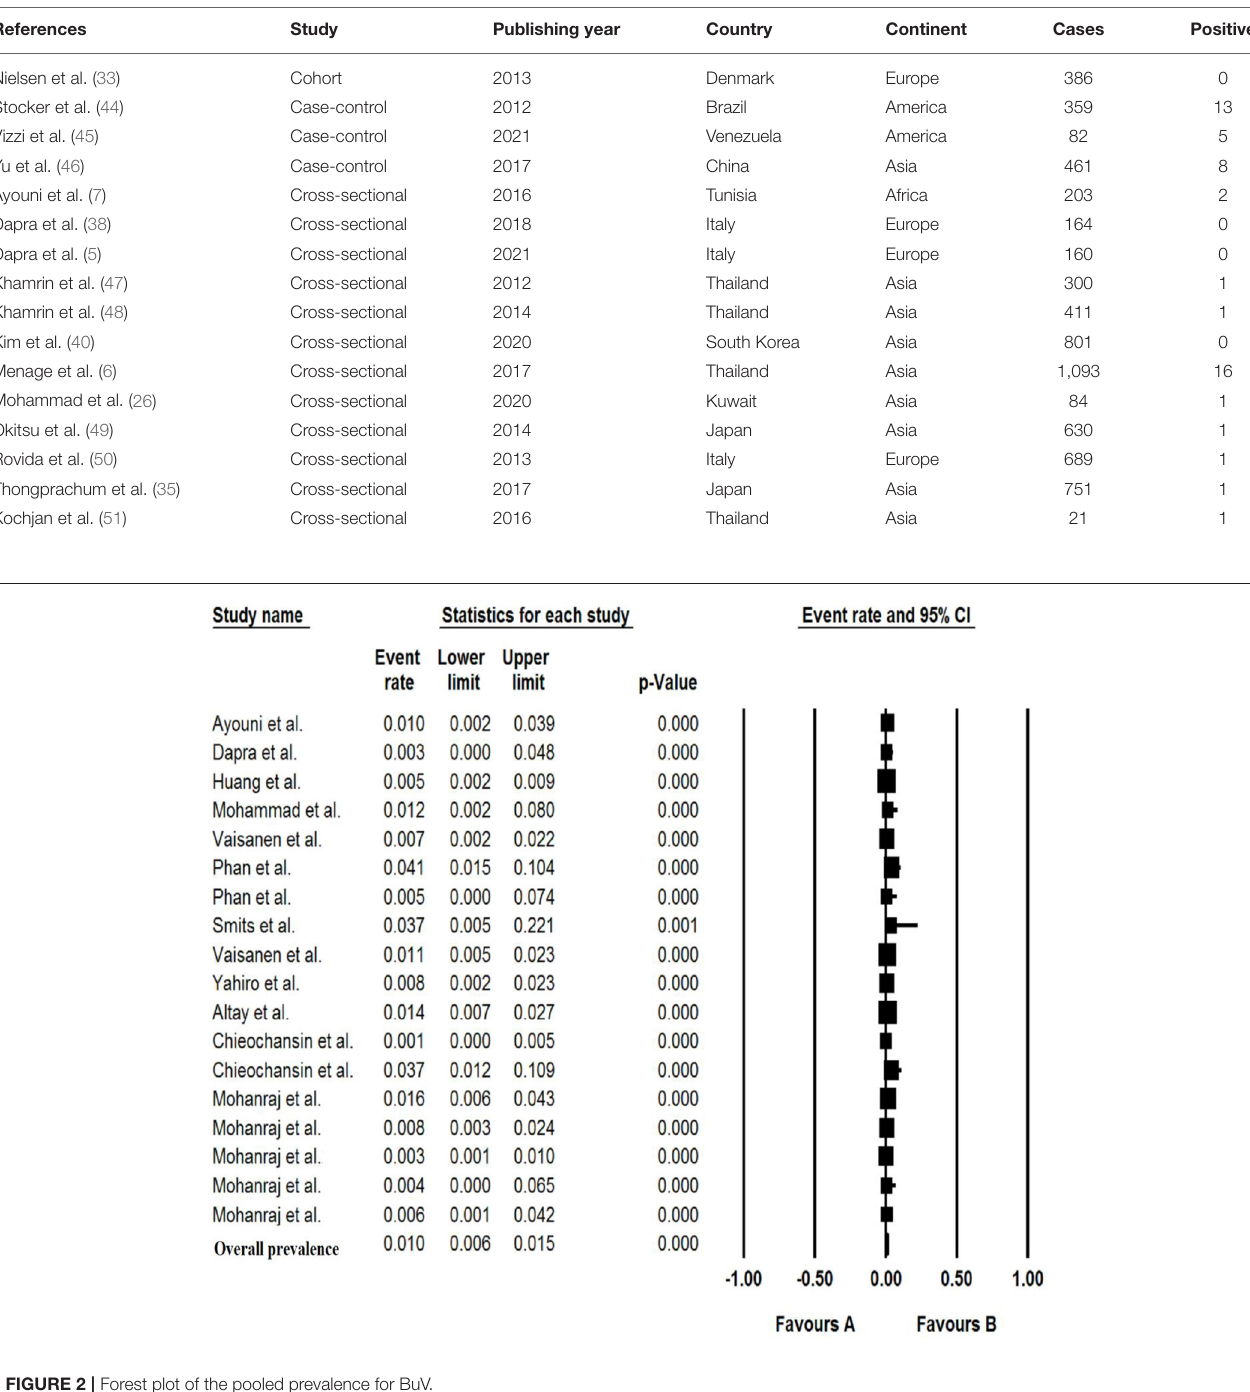
The total number of patients with GE included in this meta-analysis was 6,595 based on 16 included articles.